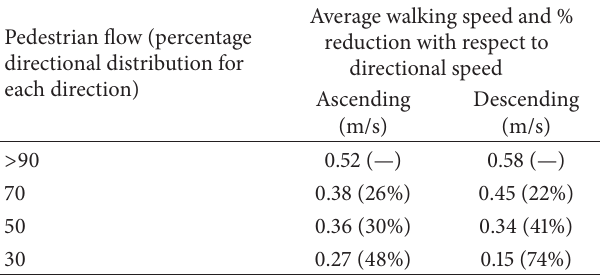
Table 2: Average walking speed and percentage reduction in major